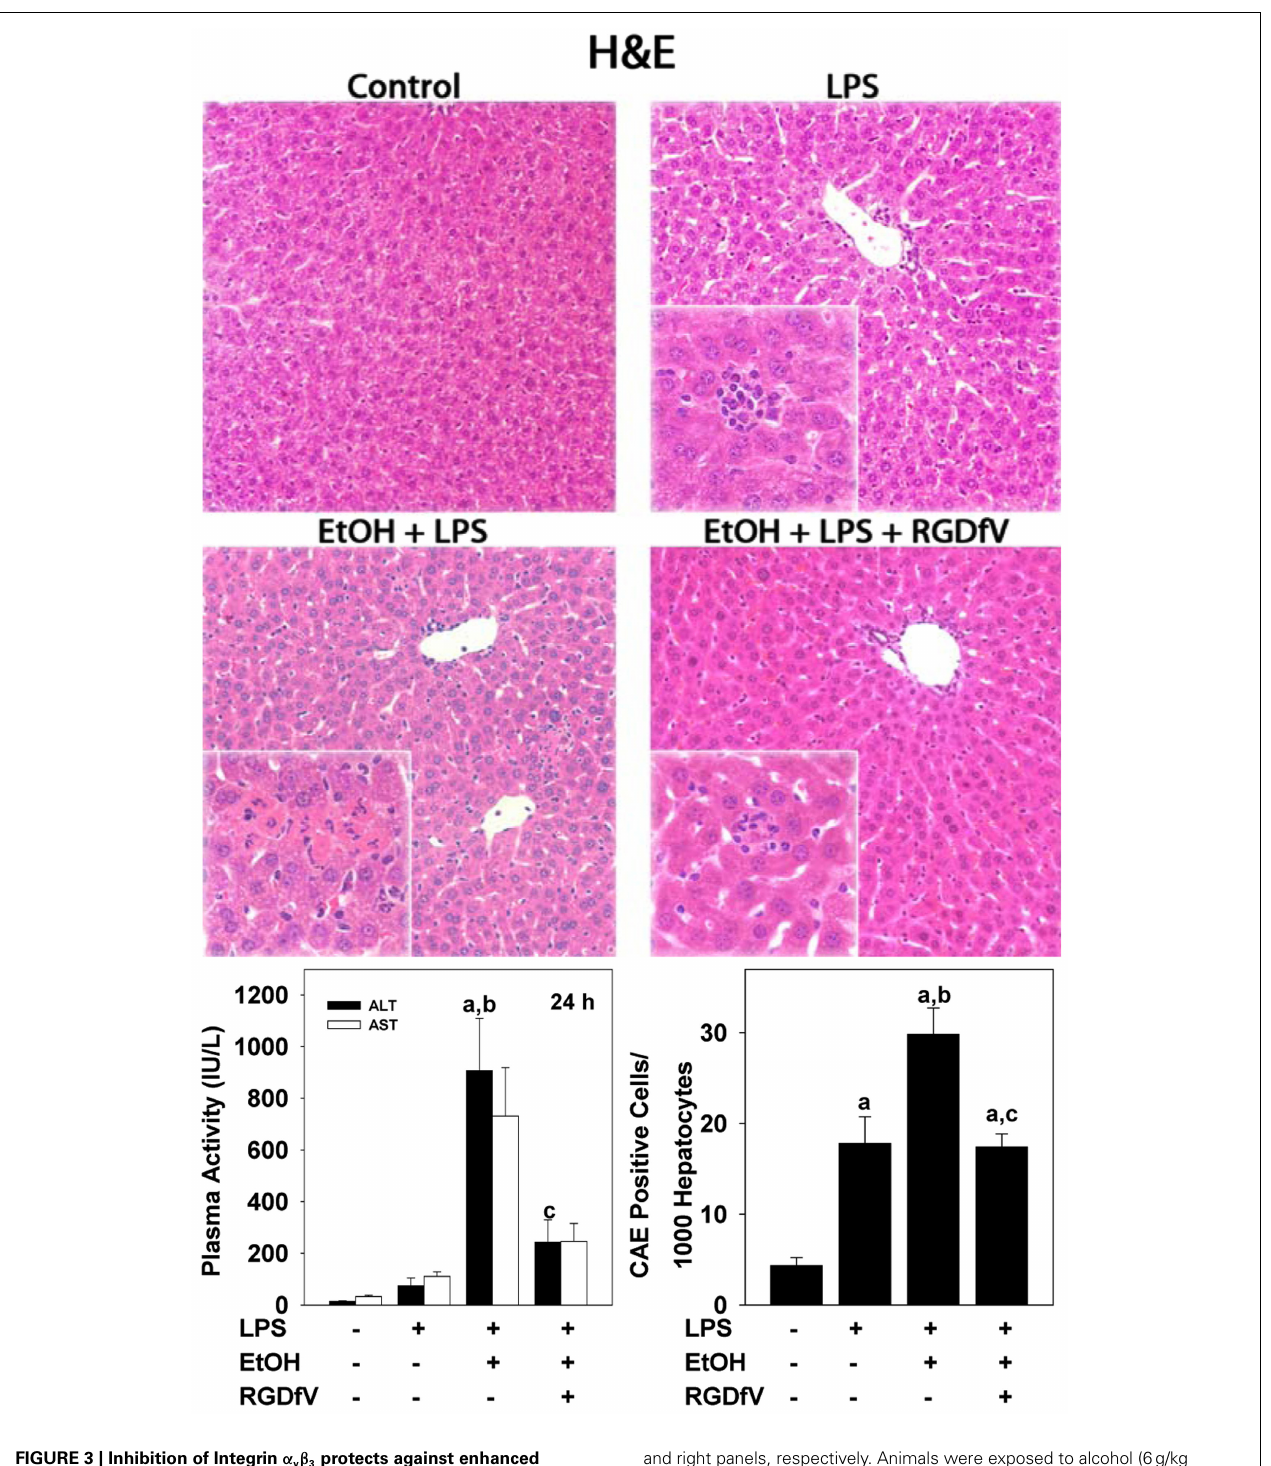
FIGURE 3 | Inhibition of Integrin α v β 3 protects against enhanced LPS-induced liver injury caused by ethanol pre-exposure. Representative photomicrographs (100 × ; insets 400 × ) of hematoxylin and eosin staining are shown in upper panel. Circulating ALT levels and neutrophil migration (determined by CAE staining) are in the lower left